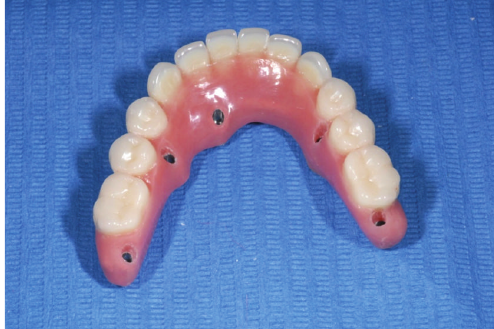
Figure 11: Final prosthesis with drilling for screw tightening.